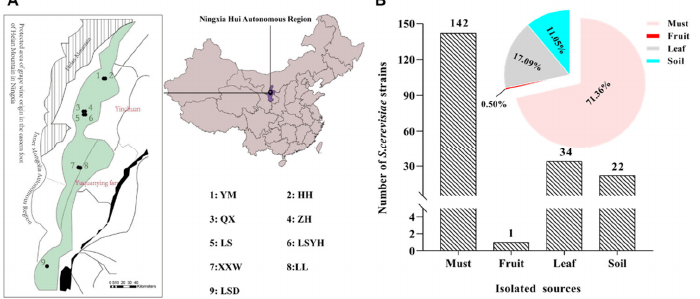
Figure 1. Sampling sites ( A ) and the number and rate of S. cerevisiae strains isolated from different sources ( B ) at the eastern foot of Helan mountain (YM: Yuma vineyard; HH: Huahao vineyard, QX: